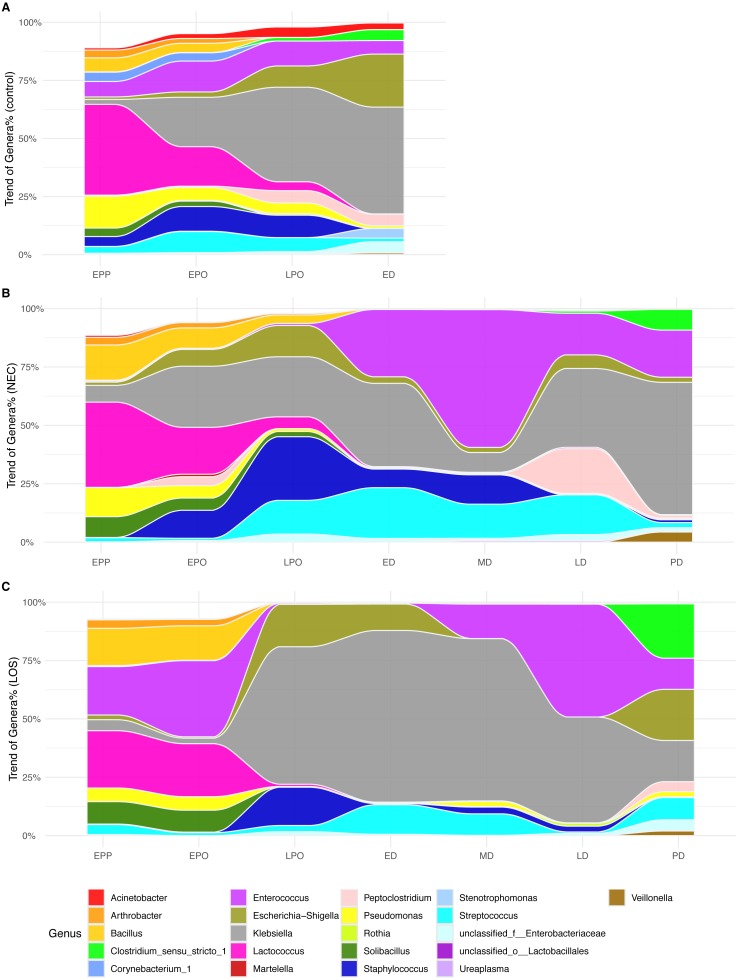
Alluvial diagrams showing temporal development of microbiome in NEC, LOS and the control groups.Genus of relative abundance over 10% were depicted. (A) Control group. (B) NEC group. (C) LOS group.